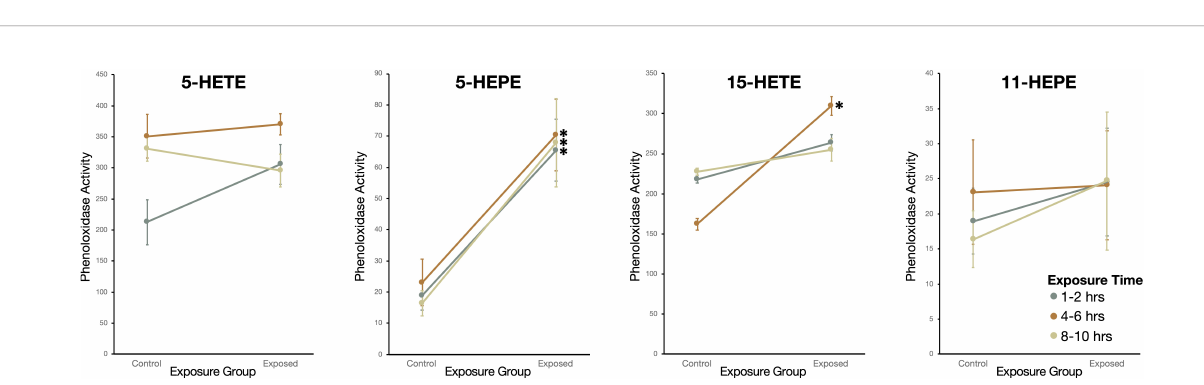
FIGURE 6 | Total haemocyte count (mean ± SE) of Stagnicola elodes snails after exposure to 5-Hydroxyeicosatetraenoic acid (5-HETE), 5-Hydroxyeicosapentaenoic Acid (5-HEPE), 15-Hydroxyeicosatetraenoic acid (15-HETE), and 11-hydroxy-5Z,8Z,12E,14Z,17Z-eicosapentaenoic acid (11-HEPE) oxylipins compared to sham- exposed snails. * P < 0.05.